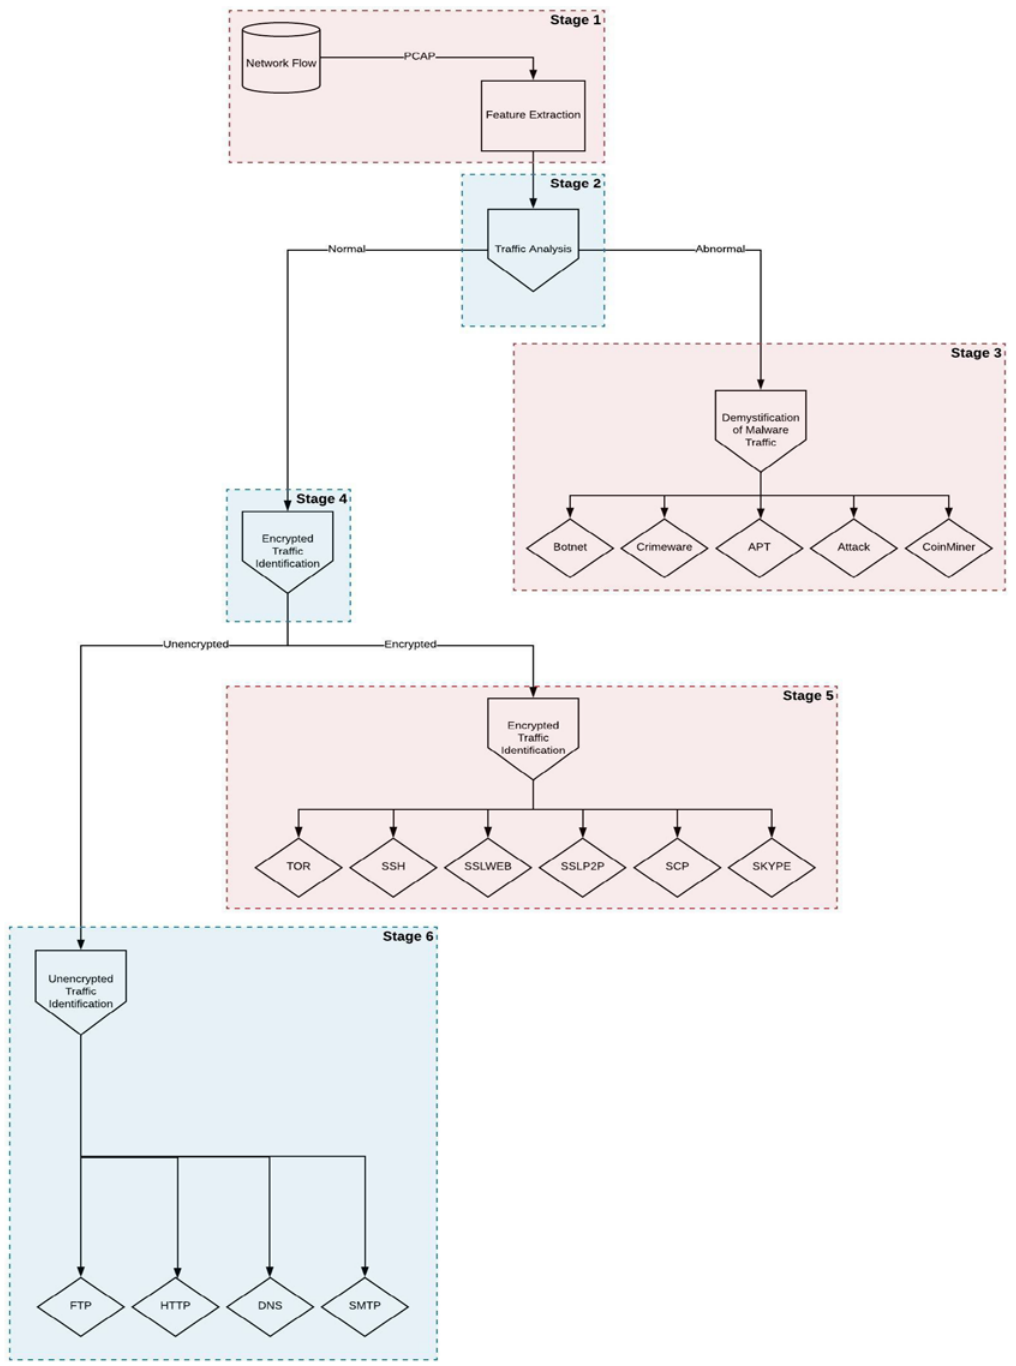
Figure 1. A depiction of the algorithmic approach of the proposed NF3 model.